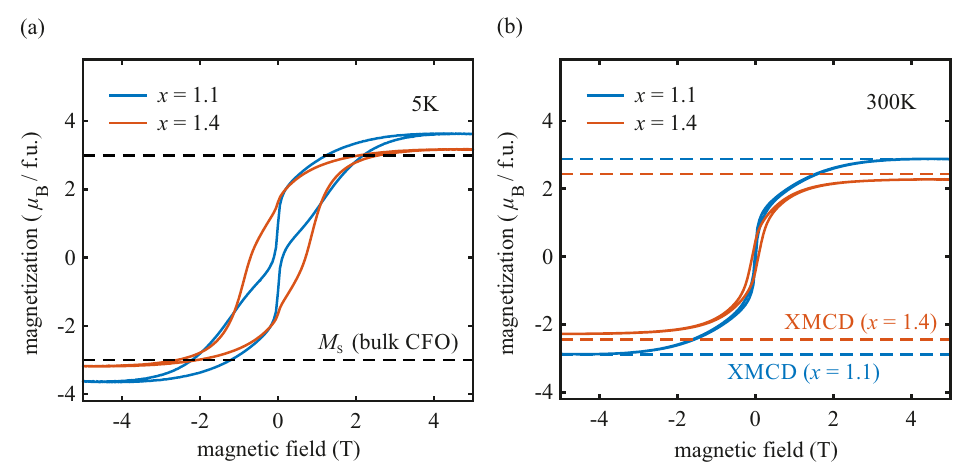
Figure 7. SQUID measurements for the Co x Fe 3 − x O 4 film with x = 1.1 and x = 1.4 at ( a ) 5K and ( b ) 300K. Dashed lines in ( a ) correspond to the values of the saturation magnetization M s for bulk CoFe 2 O 4 [1] with complete inverse spinel structure, whereas dashed lines in ( b ) correspond to the overall magnetic moments of both films as derived from the XMCD